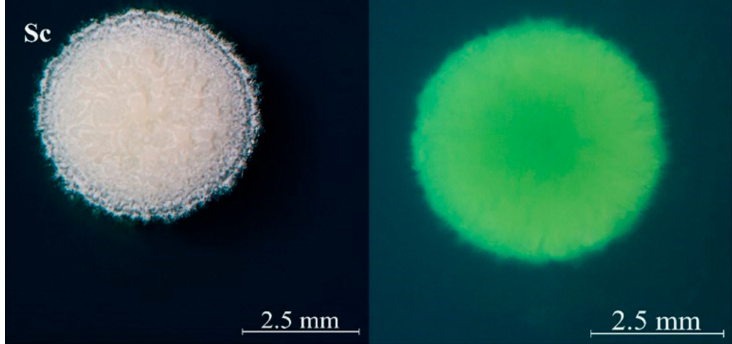
Figure 1. The colony morphology diagram of S. crataegensis